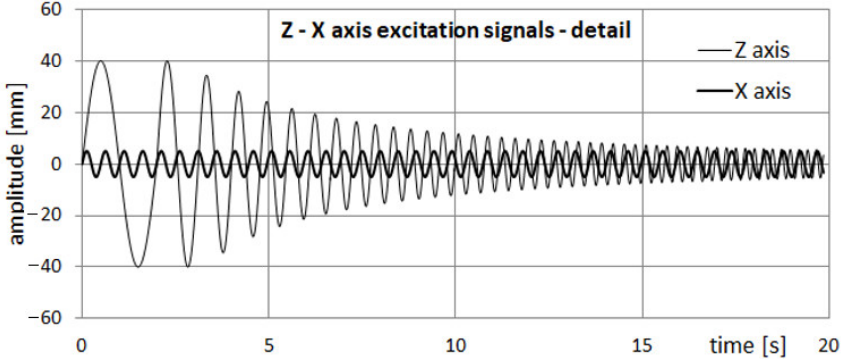
Figure 8. The example of the compound Z–X axis excitation. The Dewe 5000 measuring device was used for the measurement. Two accelerometers measured the acceleration of the table and the mass in the direction of the Z axis. The experiment was further captured by a camera, the image recording was synchronized with the measured data. The block diagram of the measurement arrangement is in Figure 9. The sampling frequency of the data was 500 Hz, the camera took 100 images per second.